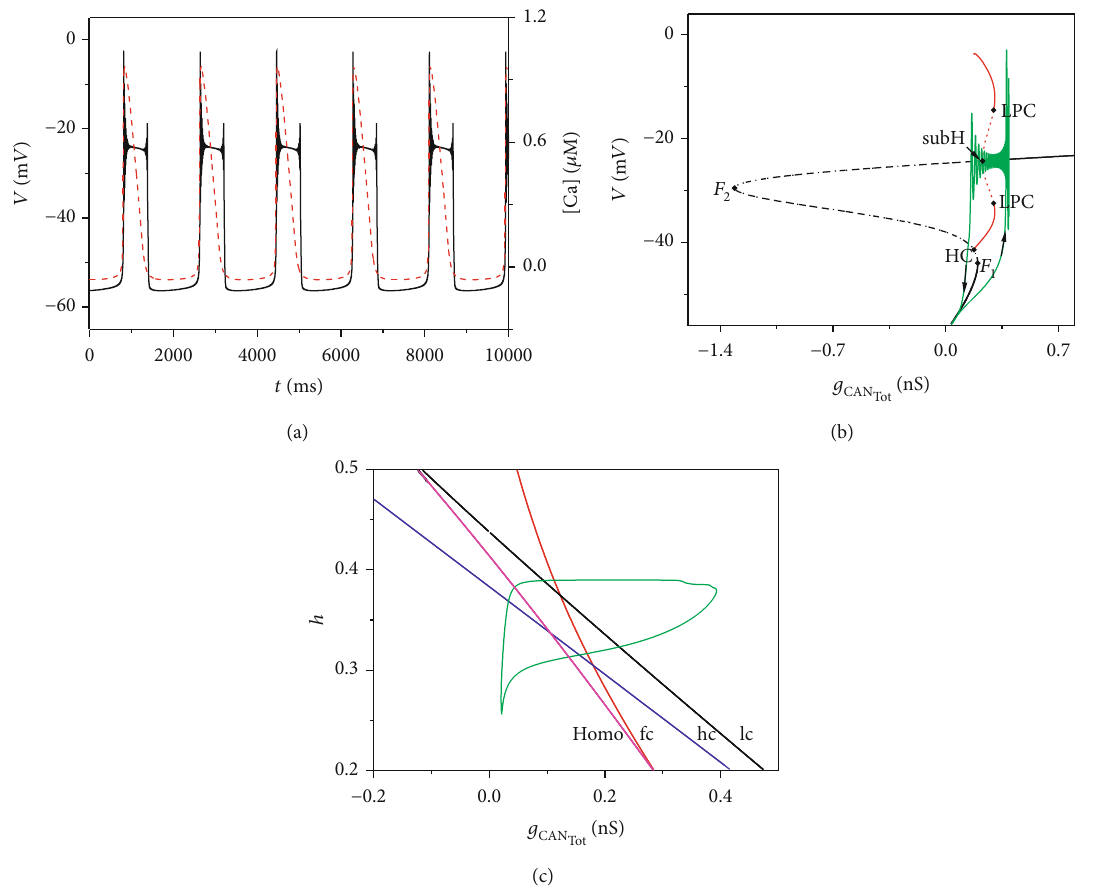
Figure 2: The dynamic analysis of system (1a) – (3b) without external stimulations ( I (black curve). The time course of intracellular calcium concentration [Ca] (red dashed line) is also superposed; (b) one-parameter bifurcation analysis of membrane potential; (c) two-parameter bifurcation analysis of membrane potential.